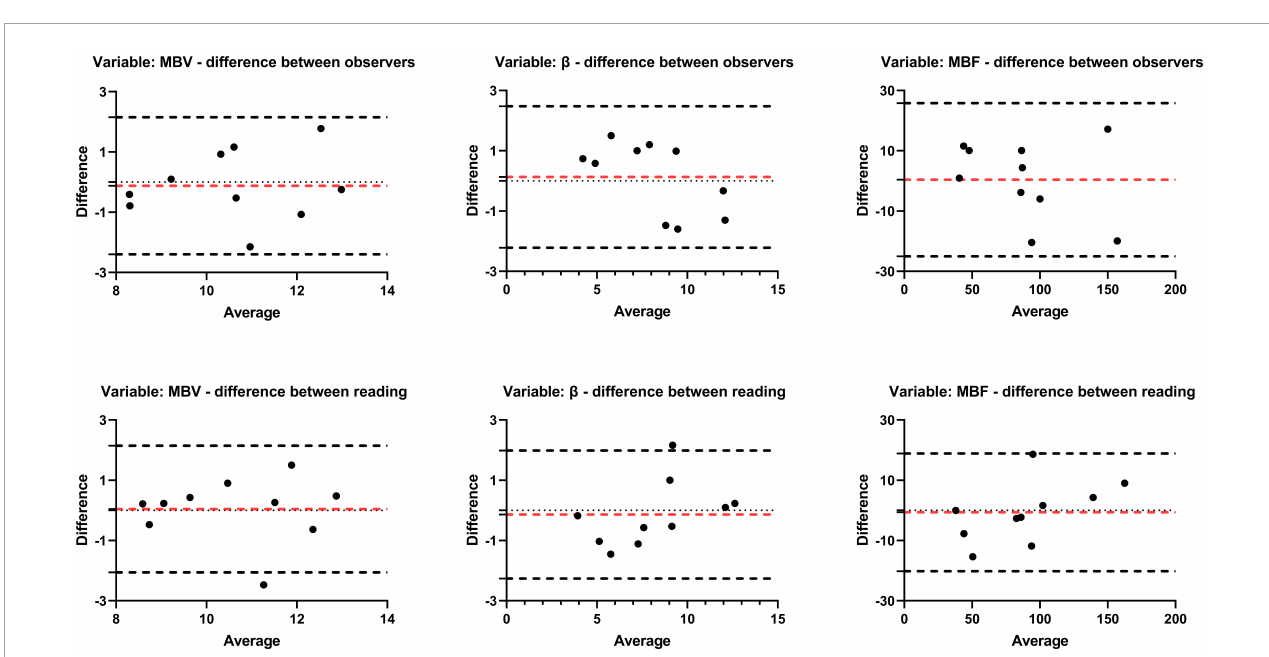
FIGURE5 Bland-Altman agreement plots of perfusion parameters (MBV, β , MBF). Plots the difference between measurements of two reading or observers and mean measurements. The top and bottom lines show the 95% limits of agreement; the middle line (red) shows the mean